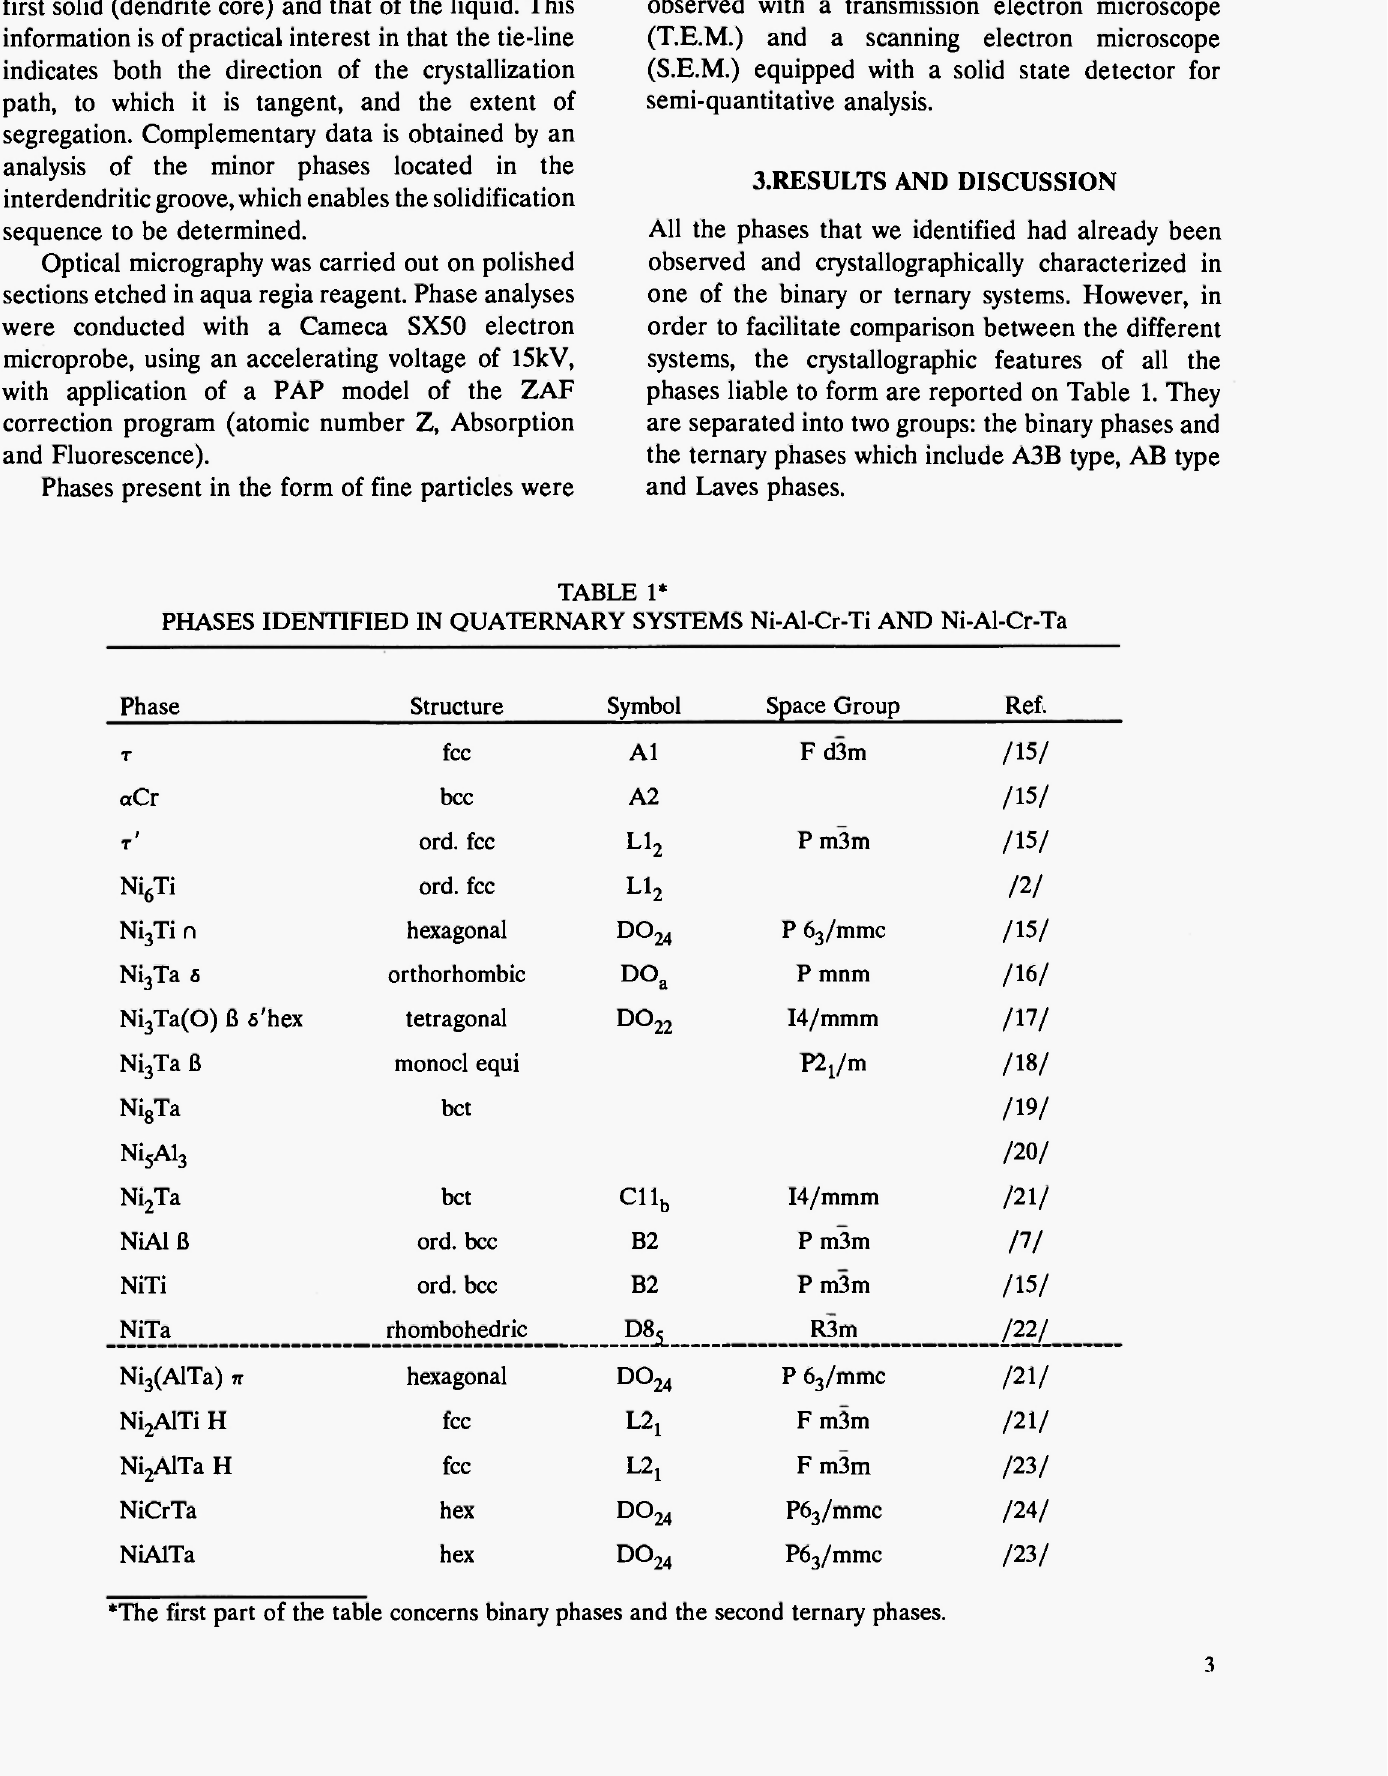
PHASES IDENTIFIED IN QUATERNARY SYSTEMS Ni-Al-Cr-Ti AND Ni-Al-Cr-Ta